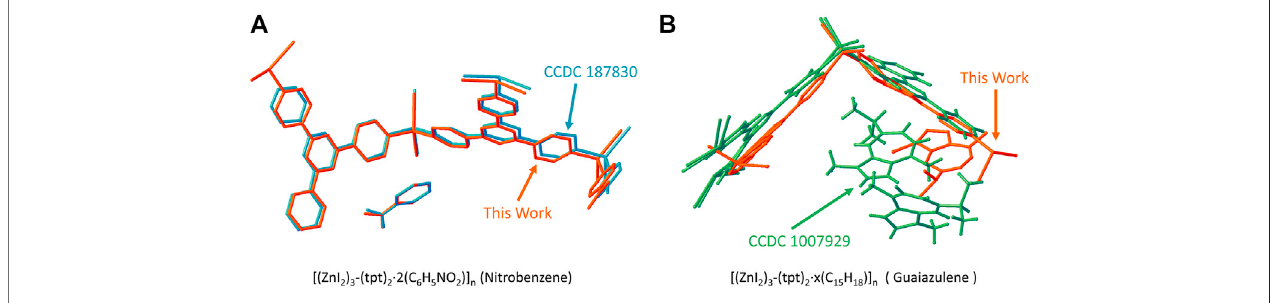
FIGURE 5 | The comparison of the structure model in this work and the reported one for (A) [(ZnI 2 ) 3 -(tpt) 2 · 2(C 6 H 5 NO 2 )] n (1-Nitrobenzene) and CCDC 187830 (Biradha and Fujita, 2002) and (B) [(ZnI 2 ) 3 -(tpt) 2 · x(C 15 H 18 )] n (1-Guaiazulene) and CCDC 1007929 (Ramadhar et al.,